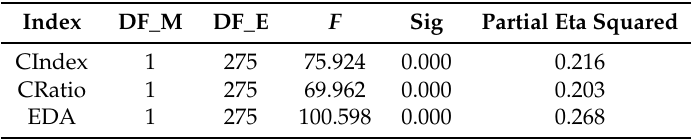
Table 3. The results of repeated measures ANOVA for selected inconsistency coefficients with problem type as within-subject factor.